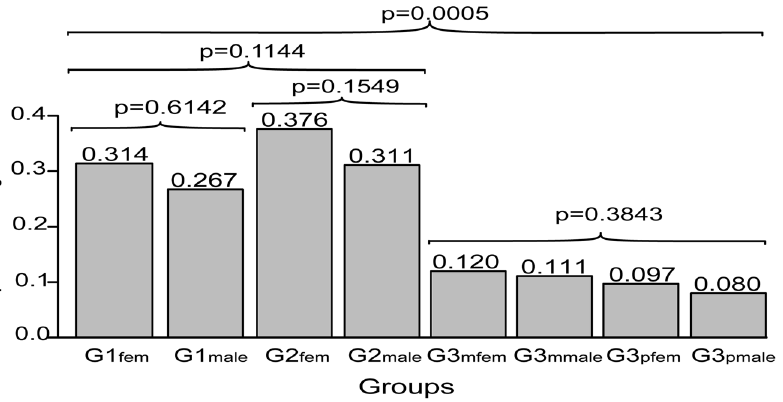
Figure 1. Proportion of migrants by sex for each generation group. P-values are shown for goodness-of-fit tests between groups.